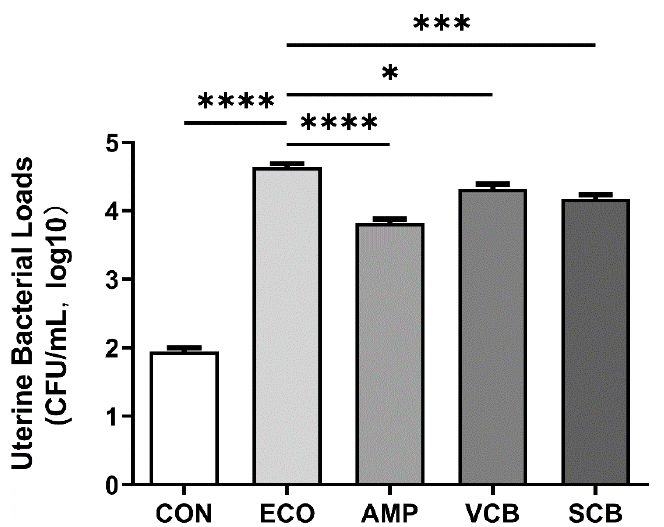
Figure 3. C. butyricum and its culture supernatant reduced the production of pro-inflammatory cytokines in uterine tissues induced by E. coli . ( A ) Uterine tissue TNF- α . ( B ) Uterine tissue IL-1 β . The values presented are the means ± SEM ( n = 6). * p < 0.05, ** p < 0.01, *** p < 0.001, and **** p < 0.0001 are significantly different from the ECO group.